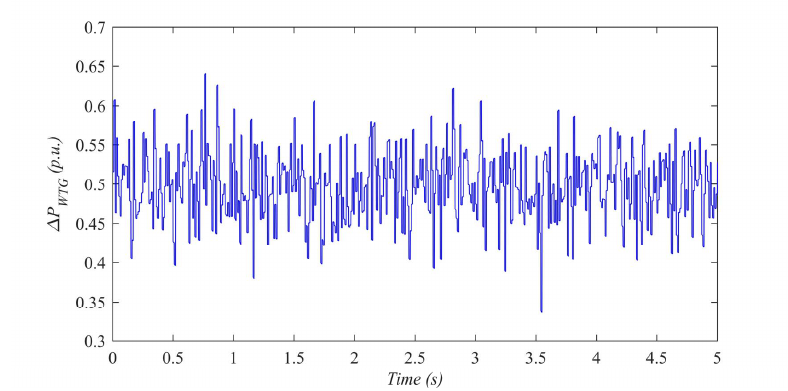
Figure 16. Stochastic power output of wind turbine generator.